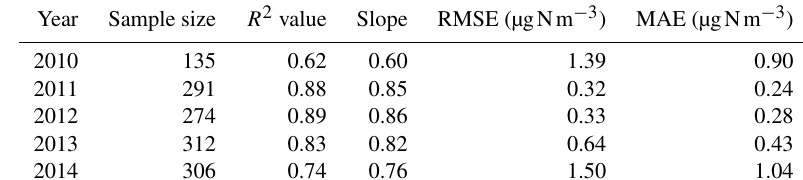
Table 1. The cross-validation result of NO